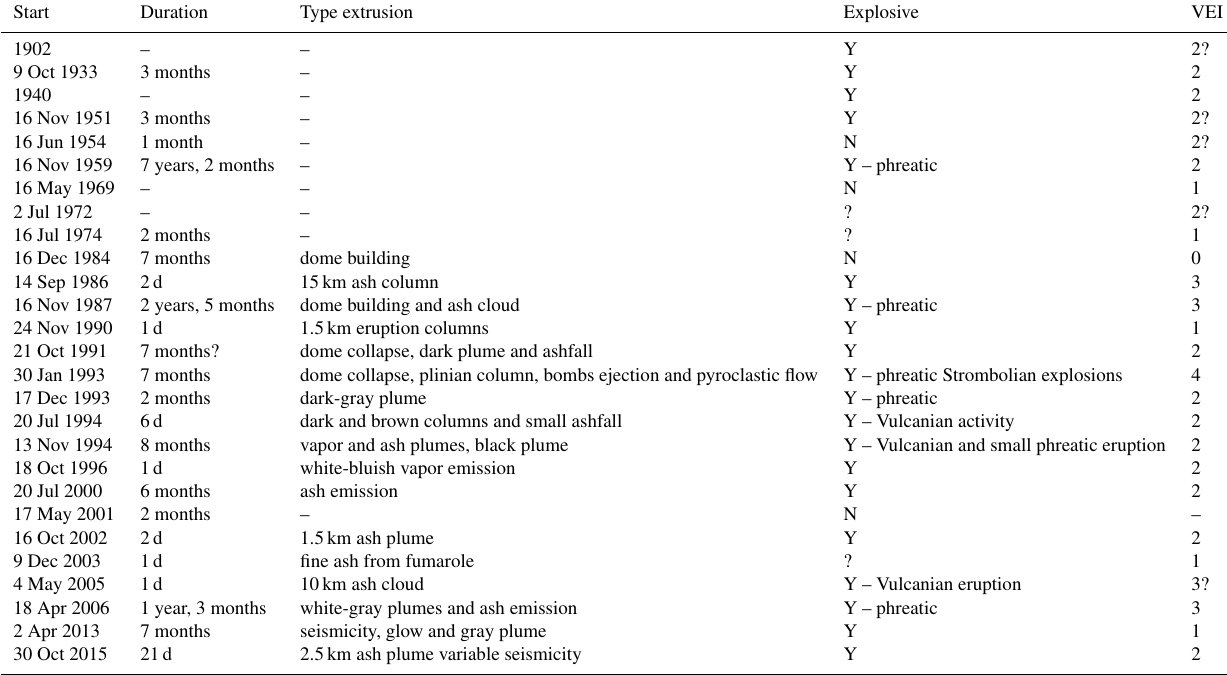
Table 1. Historical record of activity at Lascar volcano (Global Volcanism Program, 2013; González-Ferrán, 1995; Siebert et al., 2010). Start